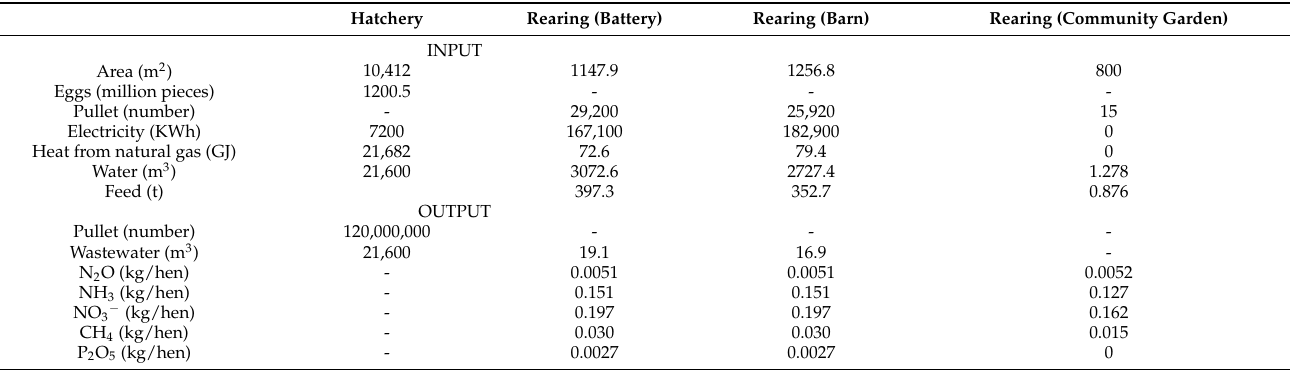
Table 1. Annual inventory data for the hatchery and rearing